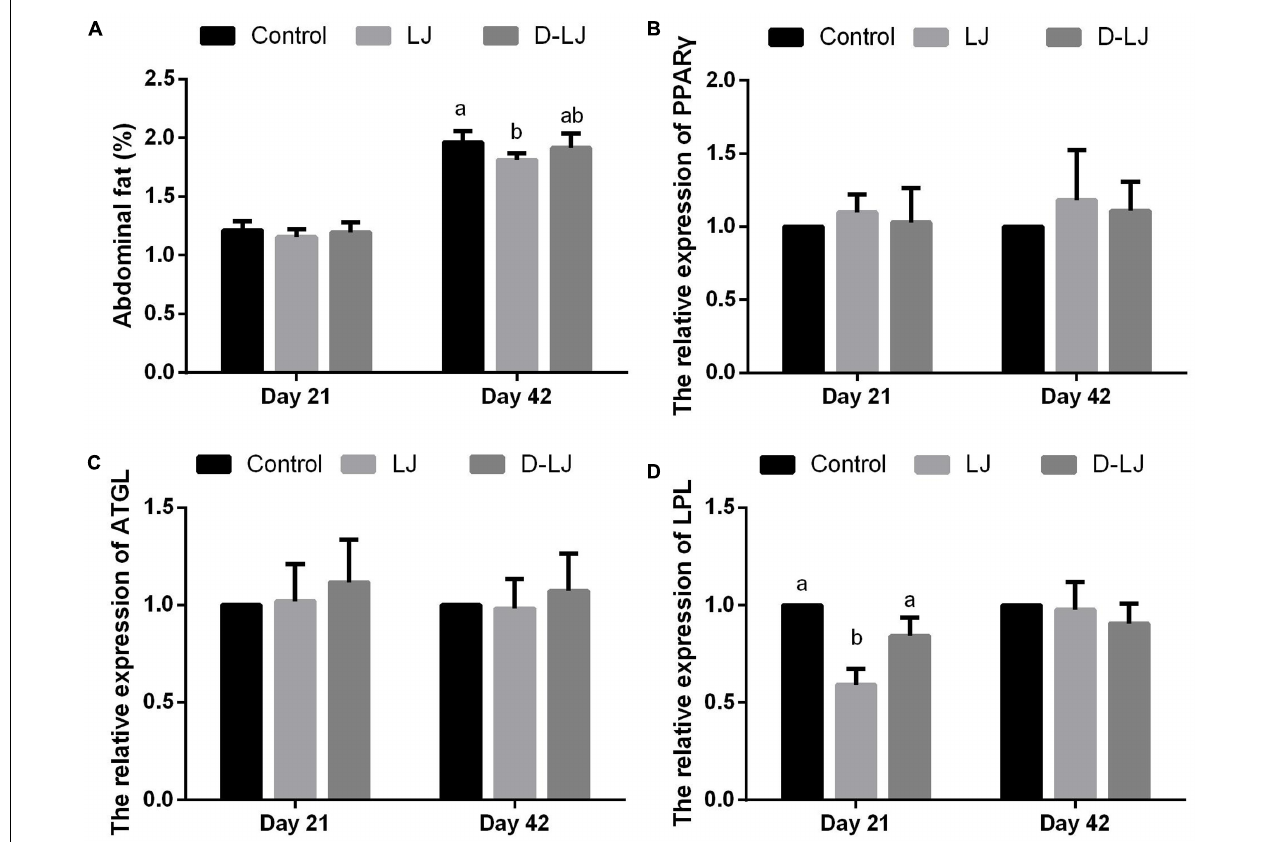
FIGURE 2 | Fat deposits and relative mRNA expression levels of lipid metabolism-related enzymes in adipose tissue. Bars with different letters are significantly different on the basis of Duncan’s multiple range tests ( P < 0.05). Data are presented as mean ± standard deviation (six replicates of one chick per cage). (A) Abdominal fat percentage; (B–D) relative expression of PPAR γ , ATGL, and LPL, respectively. PPAR γ , peroxisome proliferator-activated receptor γ ; ATGL, adipose triglyceride lipase; LPL, lipoprotein